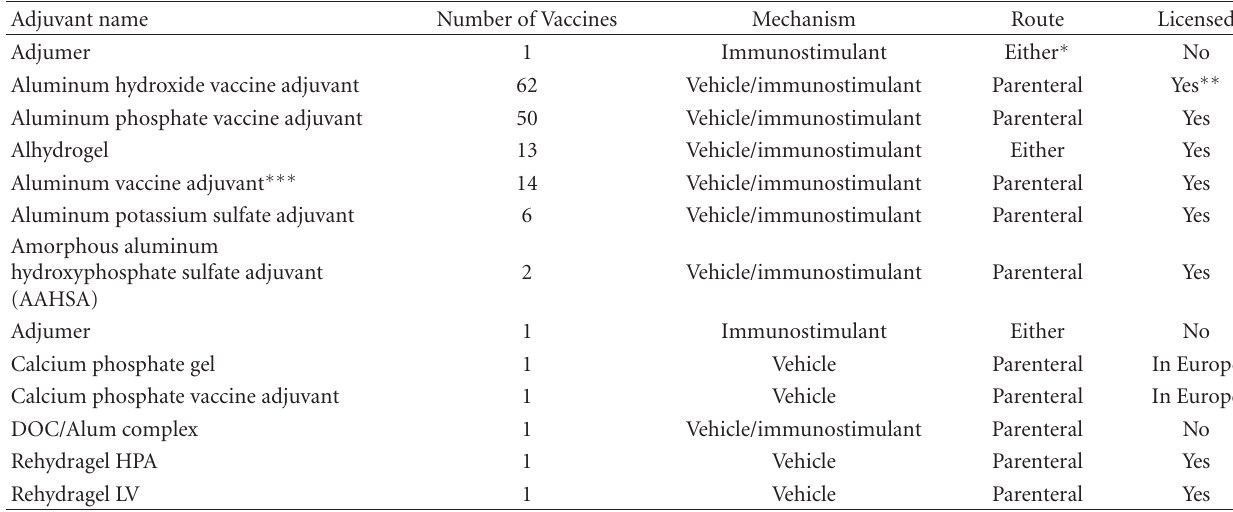
Table 2: Mineral salt